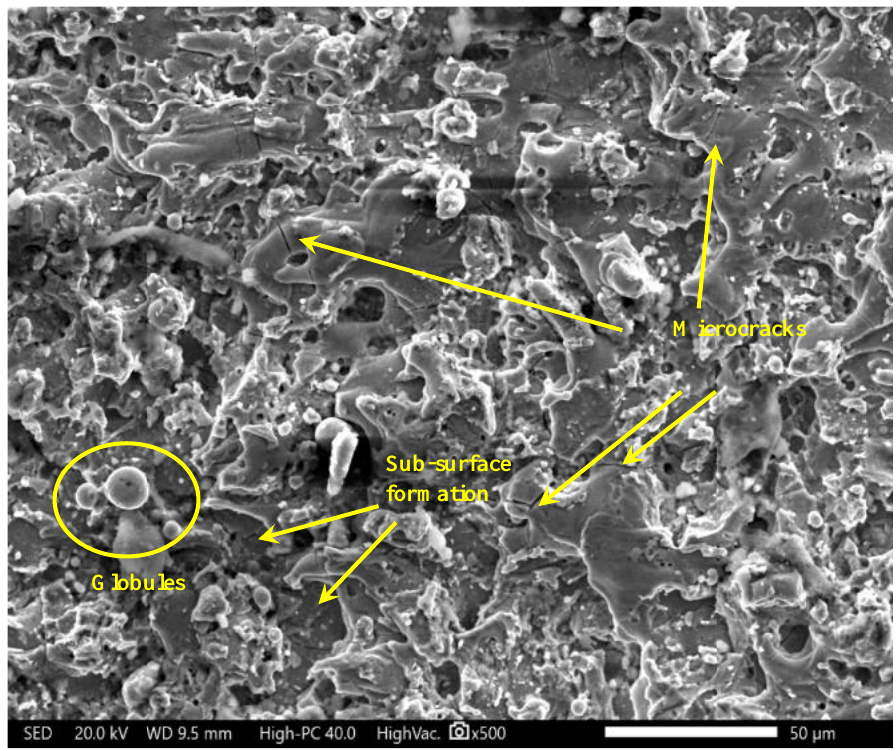
Figure 8. Morphology of machined surface.